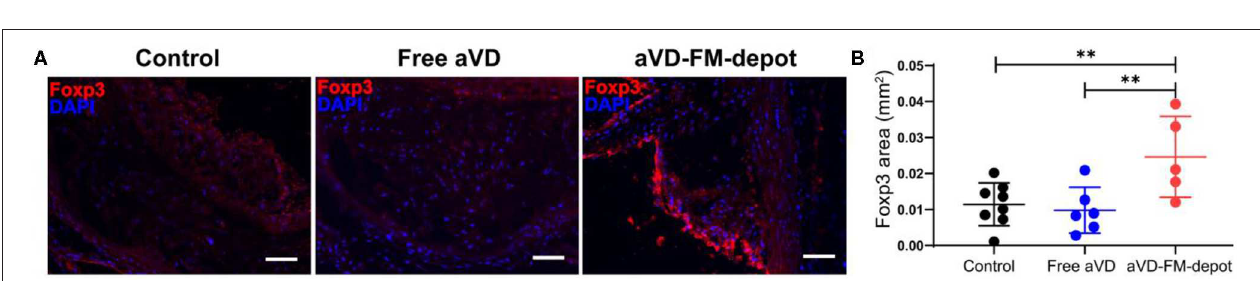
FIGURE 5 | Tregs elicited by aVD-loaded FM-depots migrate to aorta of ApoE − / − mice. (A) The expression of Foxp3 (red) was detected by immunofluorescence staining in aortic sinus of ApoE − / − mice. Nuclei were counterstained with DAPI (blue). Scale bar = 200 µ m. (B) Foxp3 + Treg content in aorta was quantified in a serial of cross sections using an in-house developed software. N = 5–8 mice per group. Two-tailed t -tests were used for statistical significance: ** p < 0.01.